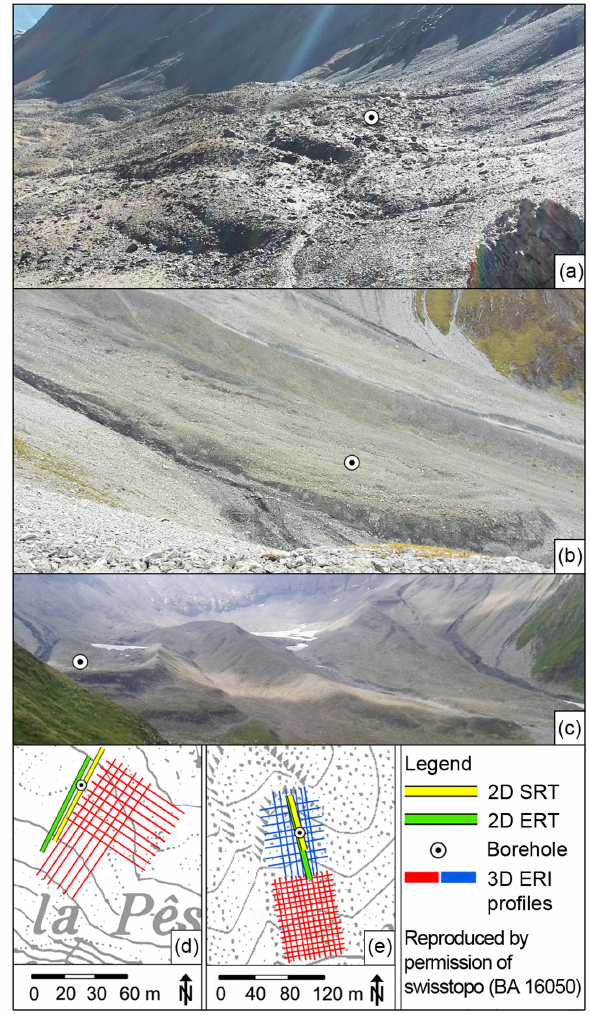
Figure 1. Site overview and measurement set-ups: (a) photo of Nair site; (b, c) photos of Uertsch site; (d) quasi-3-D ERI set-up at Nair; (e) quasi-3-D ERI set-up at Uertsch_01 (blue lines) and Uertsch_02 (red